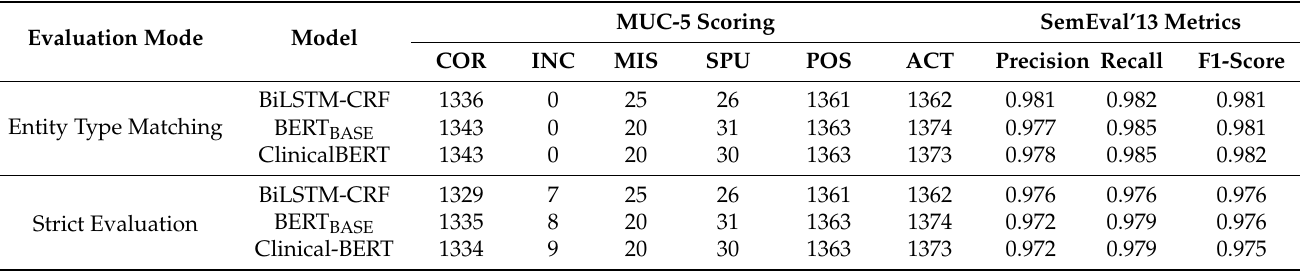
Table 3. Entity-level performance of our NER model on the test set. All three models show indistinguishably excellent performance of F1